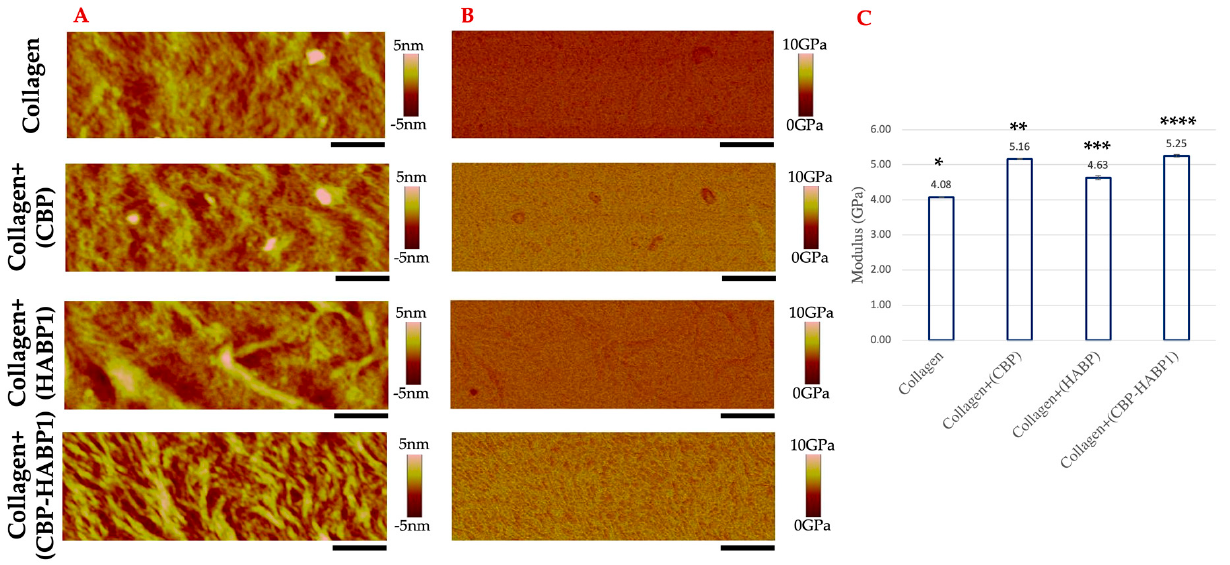
Figure 8. Mechanical properties of collagen control and peptide-functionalized collagen samples examined through PeakForce − QNM AFM. ( A ) AFM 2D-Topographical view. ( B ) DMT Modulus mapping. ( C ) Modulus averaged per pre-mineralization sample, error bars indicating standard deviation, and significant difference ( p < 0.05) is represented as *, **, ***, ****. Scale bar = 500 nm.